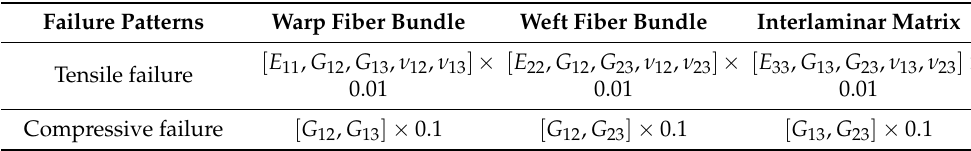
Table 3. Material degradation method used in the